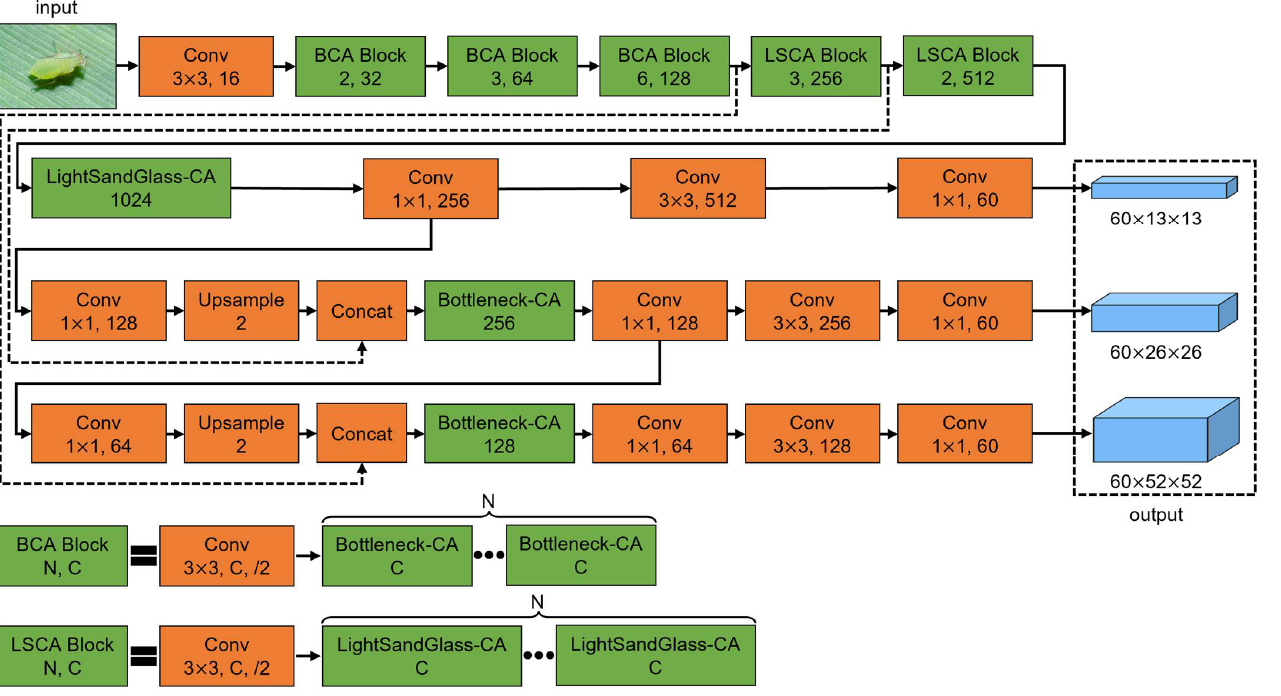
Figure 8. The structure of YOLOLite-CSG. The detailed structures of Bottleneck-CA and LightSand- Glass-CA are shown in Figure